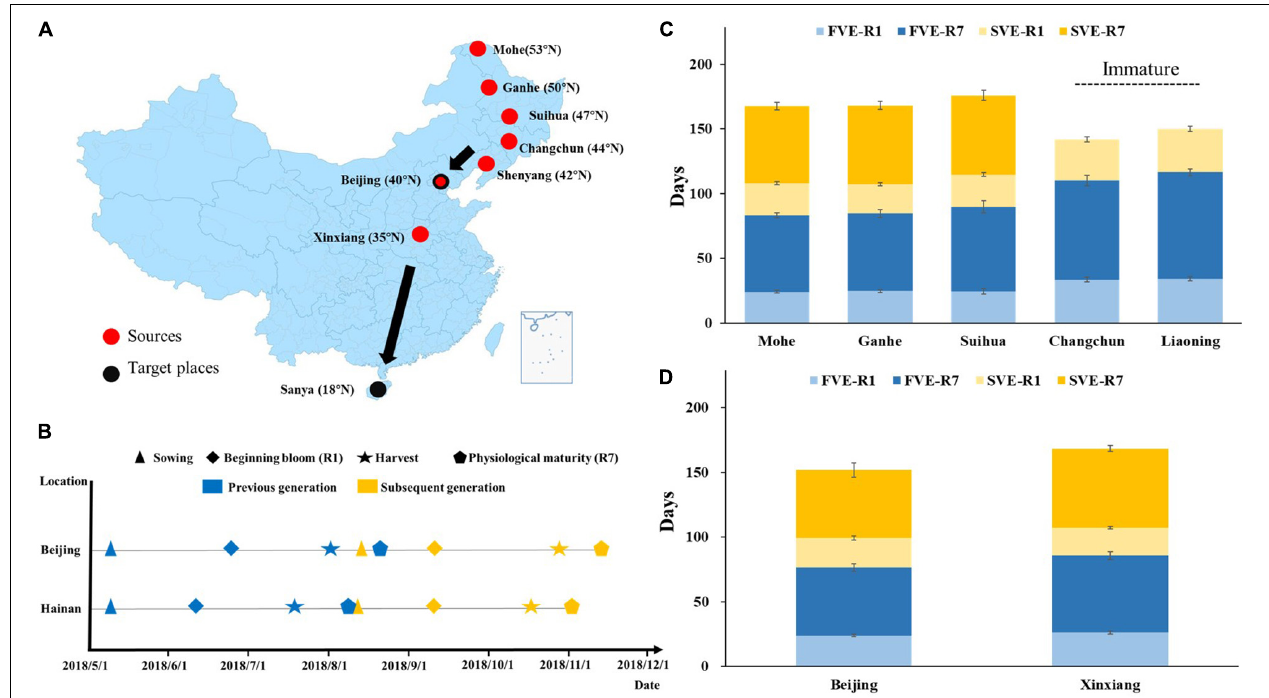
FIGURE 1 | Development of summer nursery in soybean. (A) The material sources and planting locations in summer nursery. The progenies of 34 cross combinations from Mohe, Ganhe, Suihua, Changchun, and Shenyang were planted in Beijing. The progenies of eight cross combinations from Beijing and Xinxiang were planted in Hainan. (B) Timeline of soybean development during summer nursery in Beijing and Hainan. Blue color symbols represent the developmental stages of the first generation, and the yellow color symbols represent that of the subsequent generation. Developmental stages of summer-sown soybean progenies (C) from Northeastern Spring Planting Region or (D) from Yellow–Huai–Hai Valleys Summer Planting Region planted in Hainan. F, first generation; S, subsequent generation; VE, emergence; R1, beginning bloom; R7, beginning